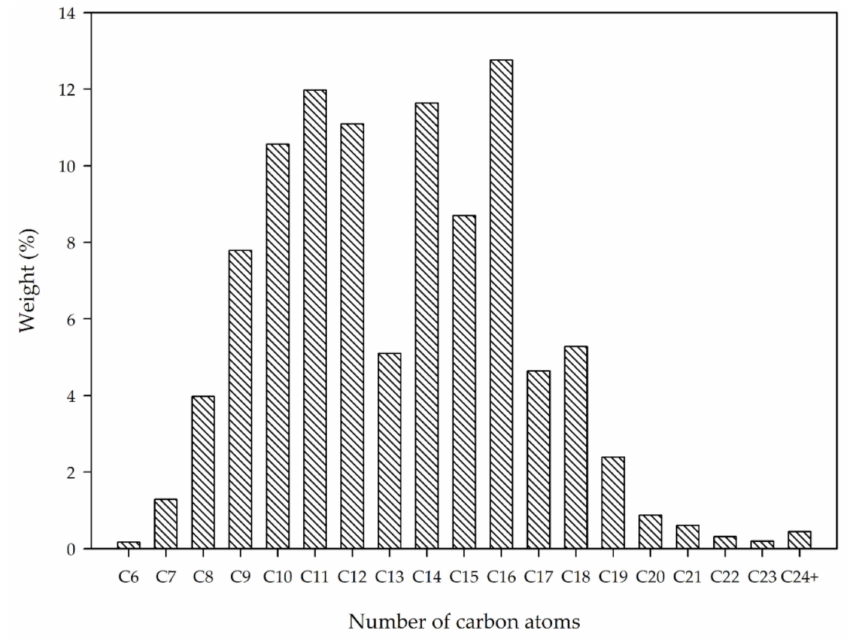
Figure 7. Number of carbon distribution as a function of percent by